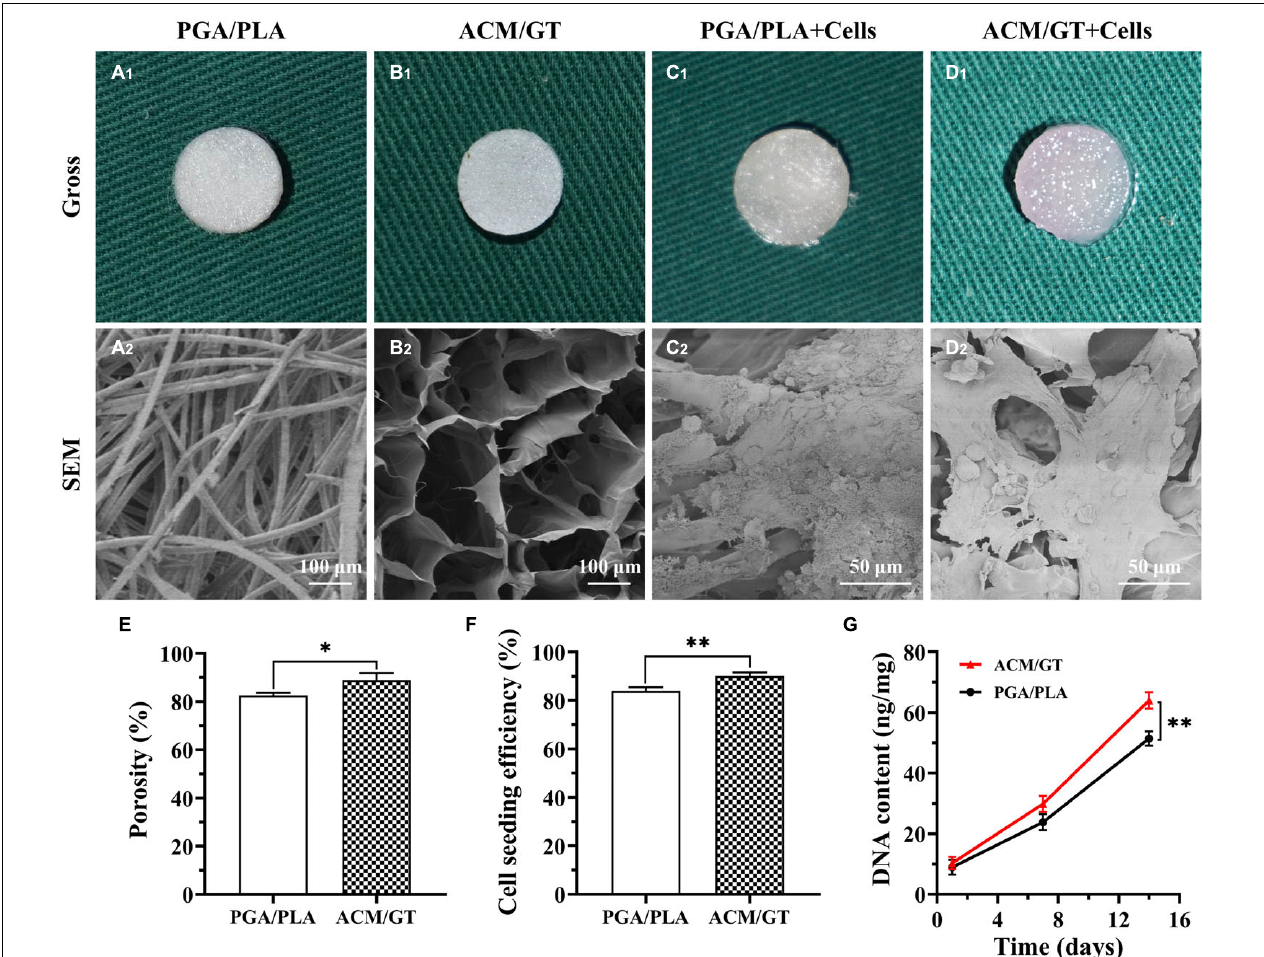
FIGURE 1 | Characterization and biocompatibility of the scaffolds. Gross and SEM images of PGA/PLA scaffold (A) , ACM/GT scaffold (B) , as well as cell-scaffold constructs (C,D) . ( C 1 ,D 1 ) Were the immediate gross images of chondrocytes seeded on scaffolds, while (C 2 ,D 2 ) were the SEM images of cell-scaffold constructs after 7 days of culture in vitro . Characterization analysis of the porosity of two scaffolds (E) . Cell seeding efficiency (F) and DNA content (G) of chondrocytes inoculated into the PGA/PLA scaffold and ACM/GT scaffold. Statistical significance: ∗ p < 0.05, ∗∗ p <